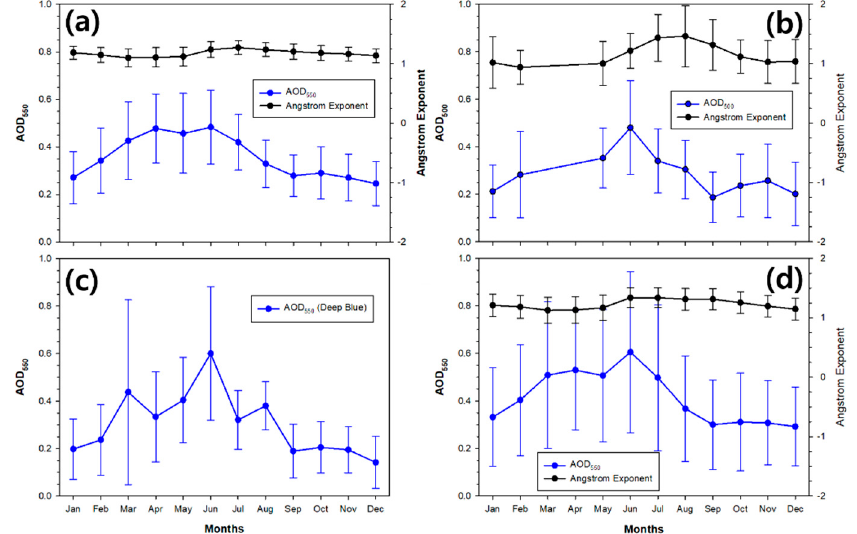
Figure 2. Monthly variation of aerosol optical depth (blue solid line) and the Ångström exponent (black solid line) with standard deviations from ( a ) Aerosol Robotic Network (AERONET) data at Yonsei University station from 1993 to 2019, ( b ) the POM-02 skyradiometer at the Korea Institute of Energy Research (KIER) station for 2021, ( c ) MODerate resolution Imaging Spectroradiometer (MODIS) products from 2020 to 2021, as well as ( d ) Modern-Era Retrospective Analysis for Research and Applications Version 2 (MERRA-2) reanalysis from 2000 to 2021.